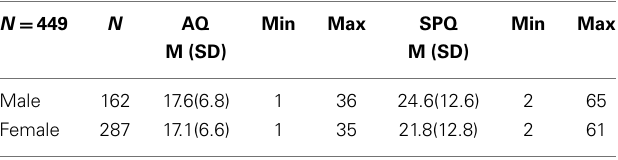
Table 1 | Mean gender difference inAQ and SPQ .